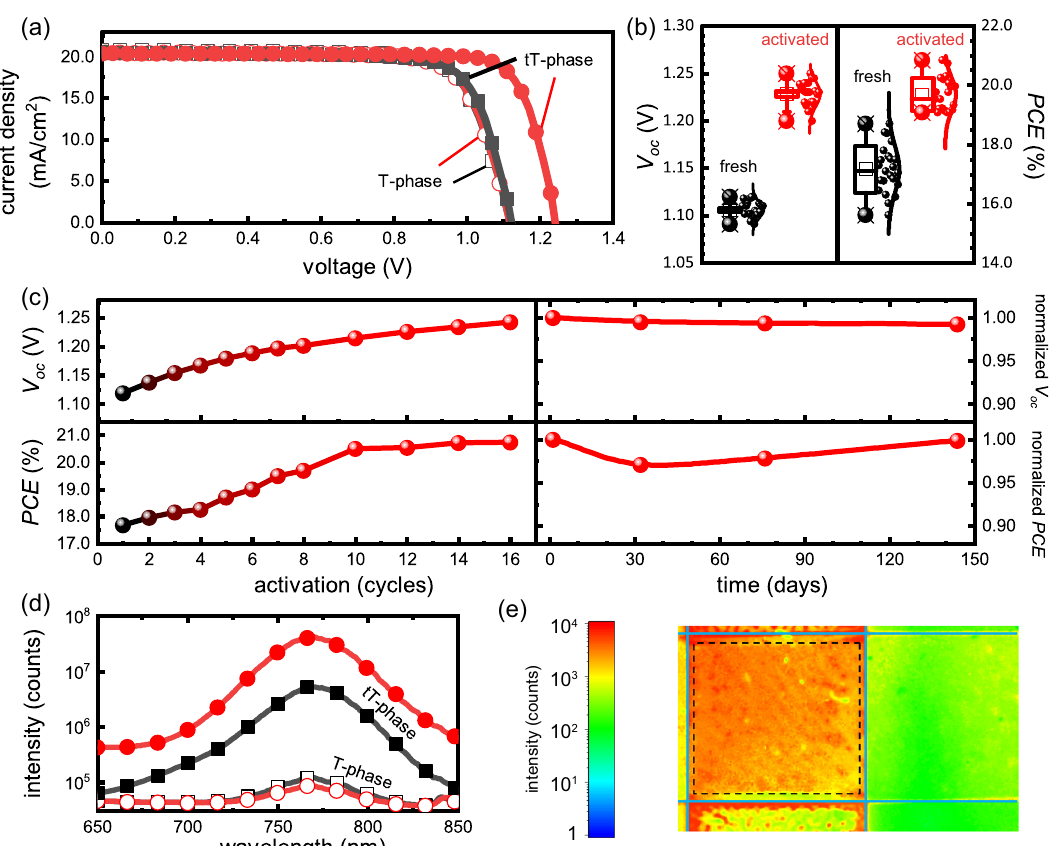
Fig. 2 | Photovoltaic performance oftT-phase solarcells. a J-Vcurvesof T-phase (open marker) and tT-phase (solid marker) MAPbI x Cl 3-x solar cells before (square) and after (circle) the activation. b V oc and PCE of fresh and activated tT-phase MAPbI x Cl 3-x over 23 devices, fi tted with normal distribution curves. c Activation process and stability of tT-phase MAPbI x Cl 3-x device. d Steady-state PL of T-phase